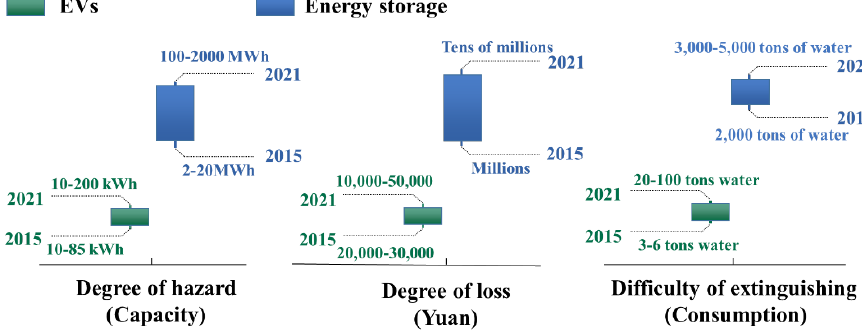
Figure 7. Comparison of fire accidents in EVs and energy storage power stations.